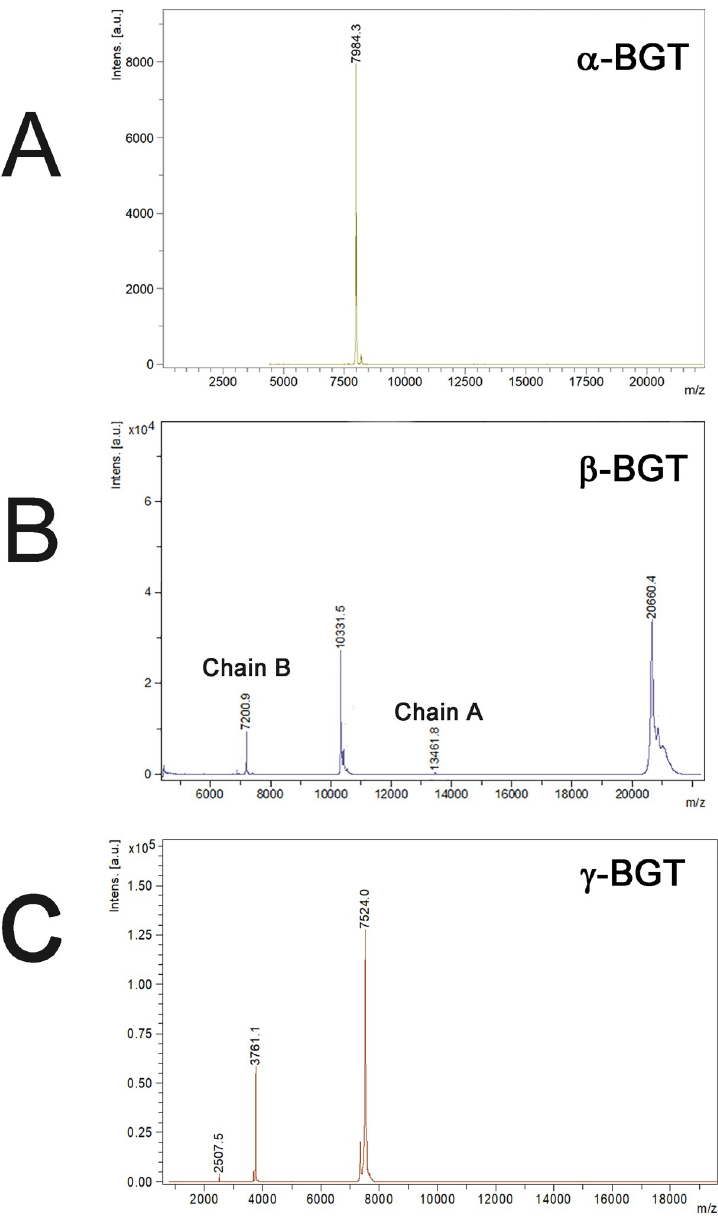
Fig 1. Molecular weight determination of purified bungarotoxins by MALDI/TOF mass spectrometer. α -BGT (A). β -BGT (B). γ -BGT (C). The recombinant MBP- γ -BGT protein was expressed in TB1 and successively purified from periplasmic fractions by an affinity column (S4 Fig). Approximately 50 mg MBP- γ -BGT protein can be obtained from 1 liter of the culture medium. The purified recombinant MBP- γ - BGT fusion protein had no lethal activity when injected i . v at high dose of 1 mg/mouse. Median lethal dose (LD ) determination 50 The LD values of α -BGT, β -BGT and γ -BGT were determined to be 0.2 μ g/g, 0.004 μ g/g and 50 0.091 μ g/g via i . p injections, 0.24 μ g/g, 0.015 μ g/g and 0.088 μ g/g via i . m injections, 0.17 μ g/g,